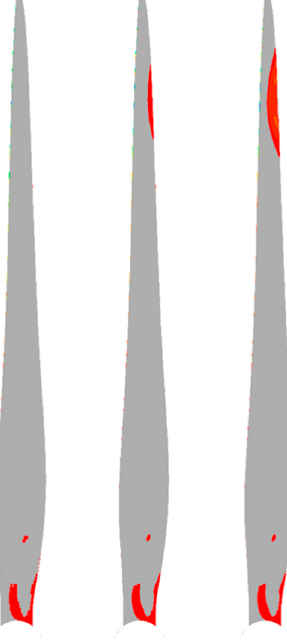
Figure 9. Zero net flow rate gusts separation region (in red) over the blade suction side at 90 ◦ azimuth angle: ( left ) ungusted case, ( center ) case with A g = 5 m / s, and ( right ) case with A g = 10 m / s.